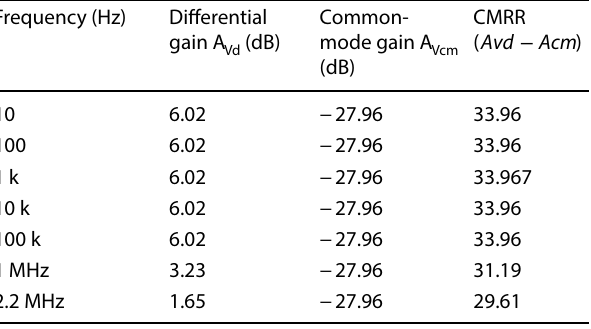
Table 2 Common-mode gain and resulting CMRR for different fre- quencies